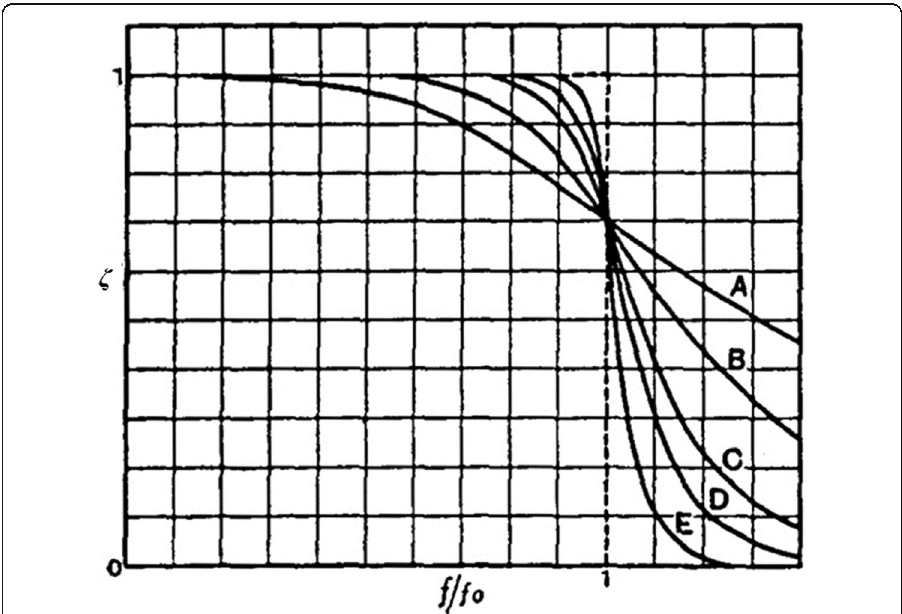
Fig. 2 The transform function of a Low Pass Butterworth Filter, where lines A through E represent orders 1 through 5